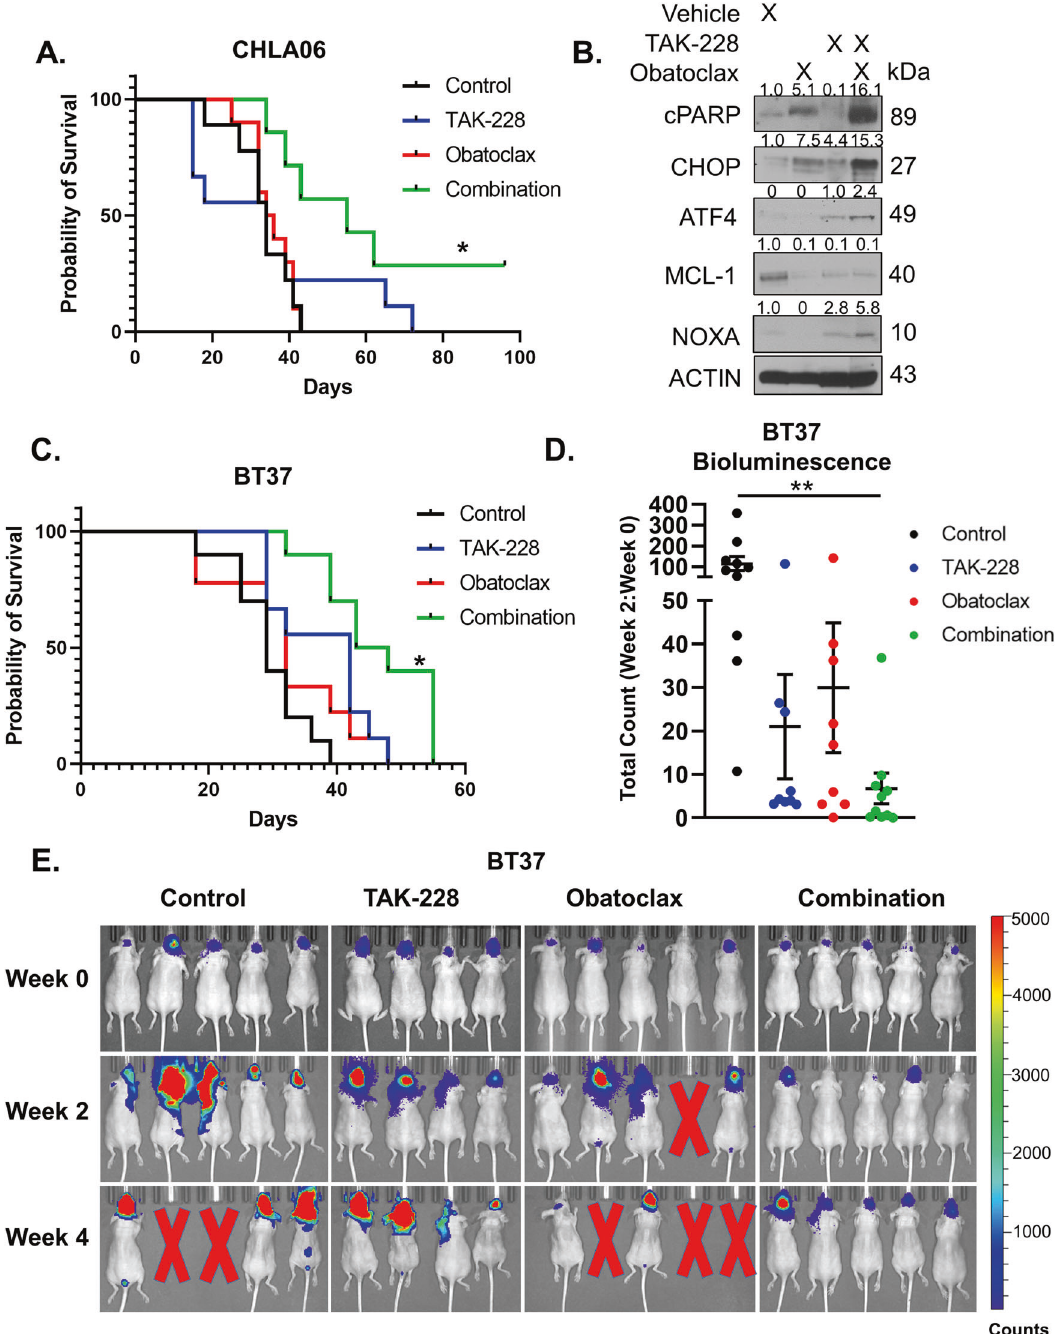
Fig. 8 TAK-228 combines with Obatoclax to slow tumor growth and extend survival in mice bearing AT/RT orthotopic xenografts. A Kaplan – Meier curve: Survival of CHLA06 orthotopic AT/RT mouse models after treatment with TAK-228 combined with Obatoclax compared with each medication alone and vehicle controls. * p < 0.05, log-rank test for combination compared with control. B Western blot of tumors dissected from mouse brains 24 h after a single treatment of vehicle alone, Obatoclax 6 mg/kg IP, TAK-228 6 mg/kg oral, or Obatoclax 6 mg/kg IP combined with TAK-228 6 mg/kg oral. Numbers above blot represent quanti fi cation of blots normalized to ACTIN. C Kaplan – Meier curve showing survival of BT37 orthotopic AT/RT mouse models after treatment with TAK-228 combined with Obatoclax compared with each medication alone and vehicle controls. *p < 0.05, log-rank test compared with vehicle control. D Graph represents the ratio of BLI quanti fi cation after 2 weeks of treatment to baseline in each treatment group. The results are presented as the mean + / − SEM, ** p < 0.005 by ANOVA. E Representative BLI in BT37 orthotopic mouse models at week 0, 2, and 4. Red X represents mice that died from tumor progression. administered IP, we felt that IP dosing would combine more experiment (Vehicle control, TAK-228 6 mg/kg oral once a week, effectively with TAK-228 treatment administered at the same time Obatoclax 6 mg/kg intraperitoneal once a week, and combination point. This combination treatment signi fi cantly improved median of TAK-228 and Obatoclax at the same doses administered survival from 29 to 44.5 days (Fig. 8C). Quanti fi cation of BLI after weekly). Given the more rapid absorption of Obatoclax when